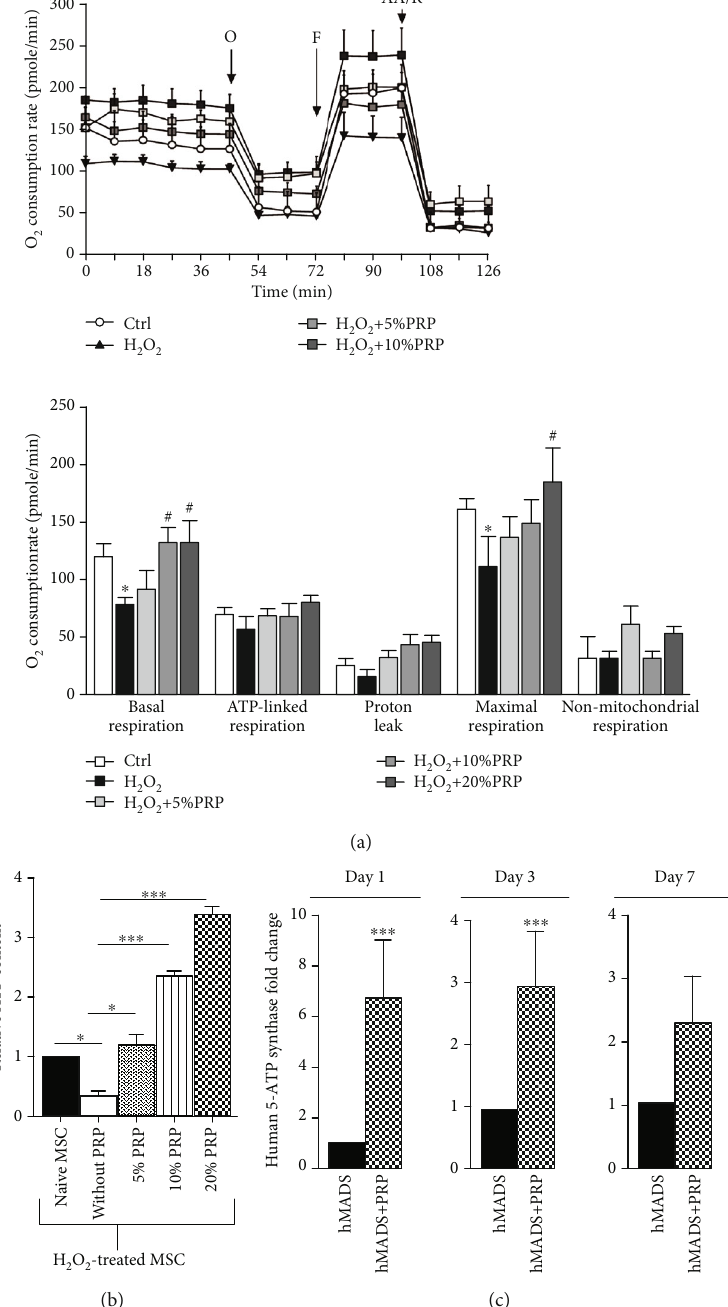
Figure 5: E ff ects of PRP on the energetic metabolism of hMADS cells. (a) Upper panel: representative graph showing oxygen consumption rate (OCR) measured by Seahorse XF analyser in hMADS cells in the absence or following a 24-hour treatment with 5%, 10%, or 20% PRP. A MitoStress assay was performed with a sequential addition of ATP synthase inhibitor oligomycin, electron chain uncoupler FCCP, and complex I and III inhibitors rotenone and antimycin A (R/AA). (b) Lower panel: mitochondrial respiration parameters including basal mitochondrial respiration (basal OCR measurement minus rotenone/antimycin A response) (basal), ATP-linked respiration (basal OCR measurement minus oligomycin response), proton leak (oligomycin response minus rotenone/antimycin A response), maximal respiration (FCCP response minus rotenone/antimycin A response), and nonmitochondrial respiration (rotenone/antimycin A response). Results obtained from n = 5 independent experiments are expressed as mean ± SEM ; # p < 0 : 05 . (b) Relative ATP content of H cells in the absence (without PRP) or following treatment with 5%, 10%, or 20% PRP by reference to noninjured naïve hMADS cells. Data represent the mean ± SD of n = 5 independent experiments. ∗ p < 0 : 05 , ∗∗∗ p < 0 : 001 . (c) Relative human 5-ATP synthase transcriptional expression in mouse wounds corresponding to the expression of hMADS cells engrafted in combination with PRP by reference to the expression of hMADS cells engrafted alone, at day 1, day 3, and day 7 postinjury. Data represent the mean ± SD from n = 6 mice. ∗∗∗ p < 0 : 001